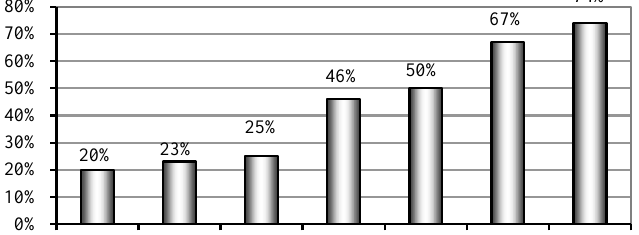
Figure 1. OVERT PRONOMINAL SUBJECTS THROUGH SEVEN PERIODS